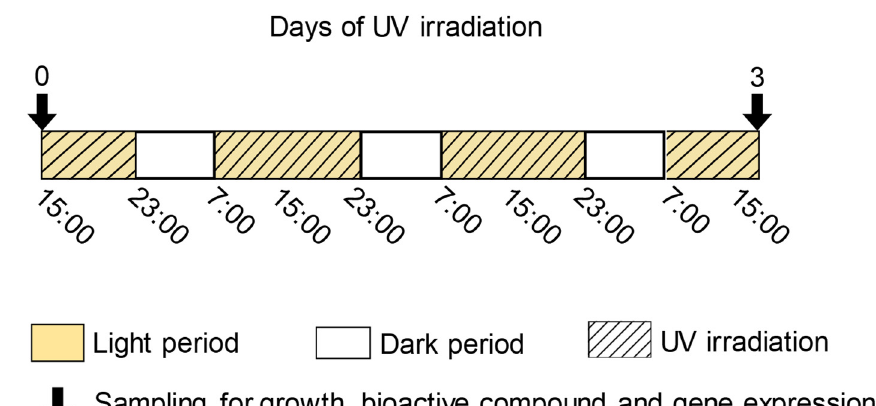
Figure 2. A schematic representation of UV-B sampling and exposure times (experiment 1). UV-B irradiation intensity was set to 0, 6, and 10 W m − 2 . Sampling was conducted at 0, 24, 48, and 72 h for the analysis of time-dependent responses to UV-B irradiation.